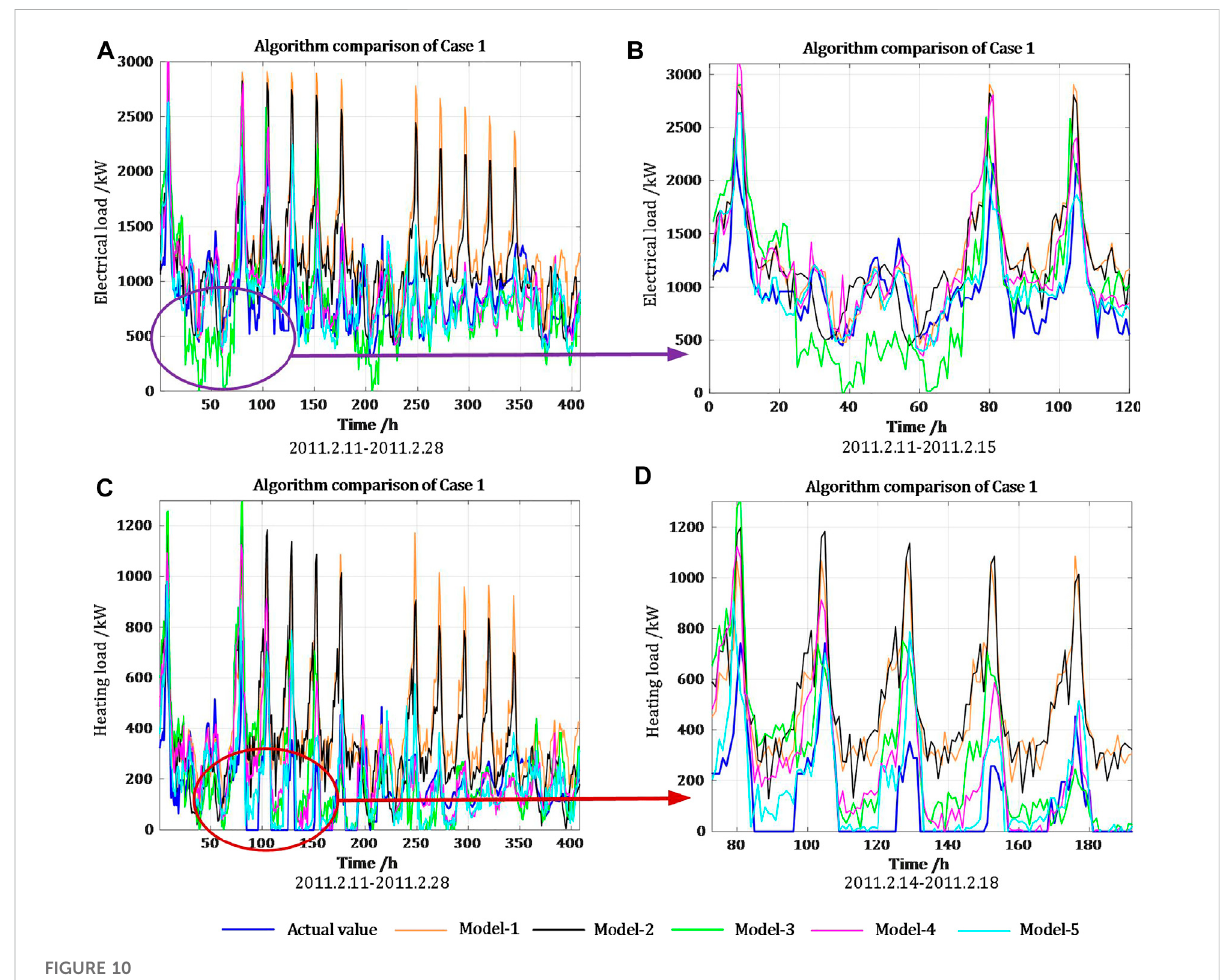
FIGURE 10 Comparison of the details in Case